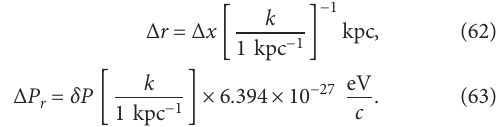
Where the new mean ⟨(…)⟩ function W ( x )